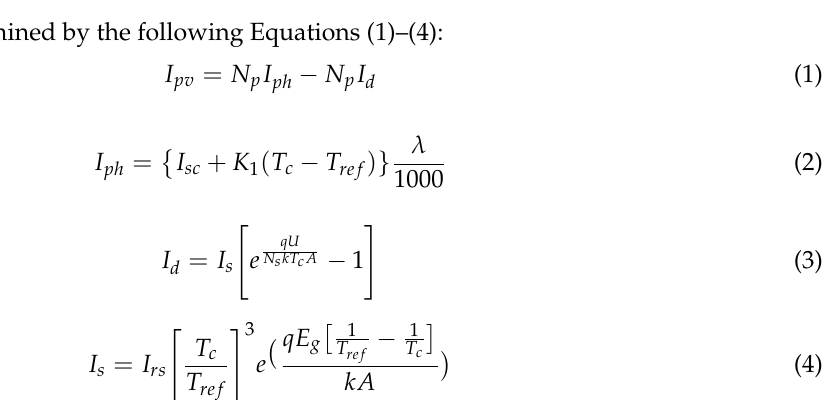
Figure 2. Equivalent Circuit of solar